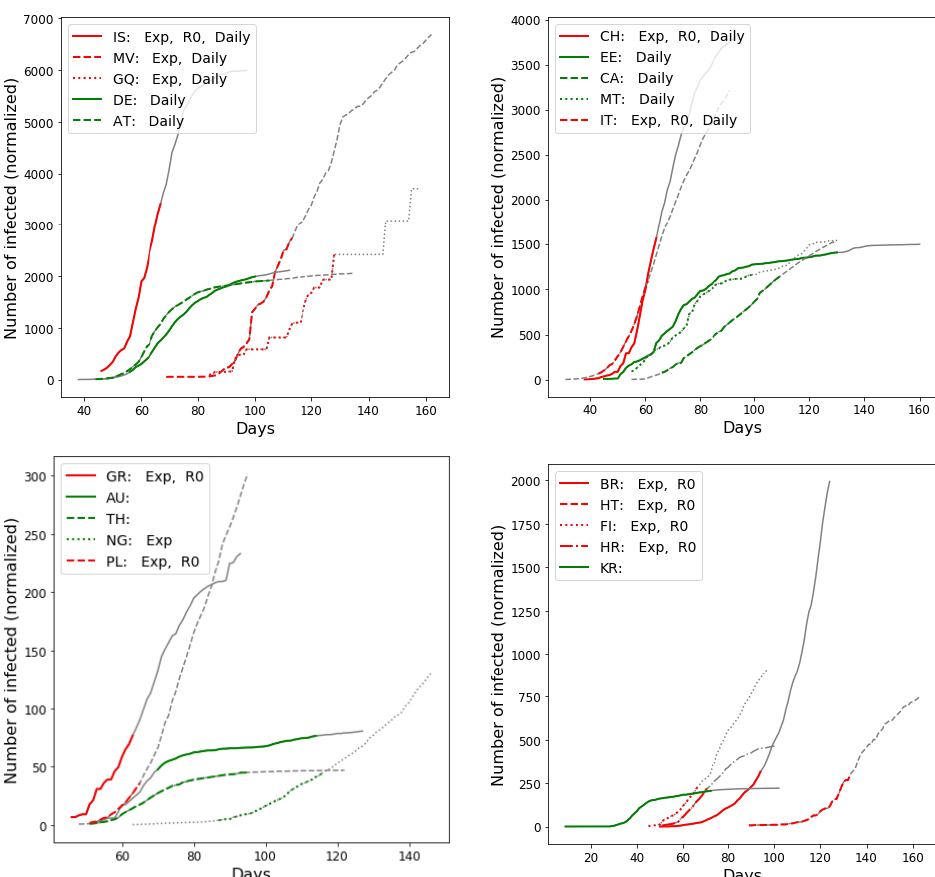
Figure 3. A sample of 20 curves, each representing infection progress in a different country. The legend shows the ISO code of the country and which classes are positive. A line is red if at least two out of three metrics label the country as positive. Gray lines indicate the part of the time series outside the time interval used for our